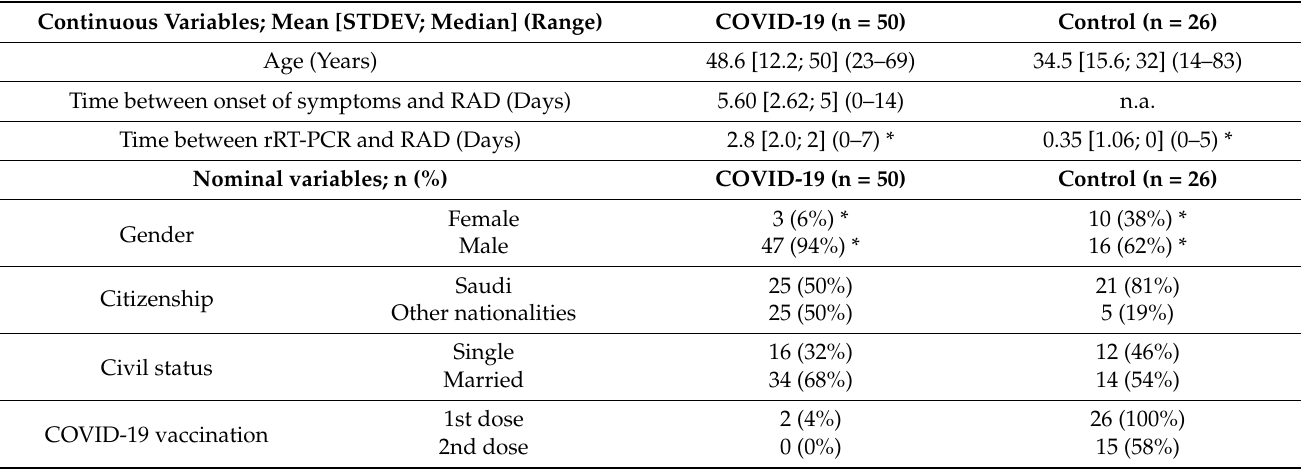
Table 1. Demographic description. Descriptive data show the patient demographics in the